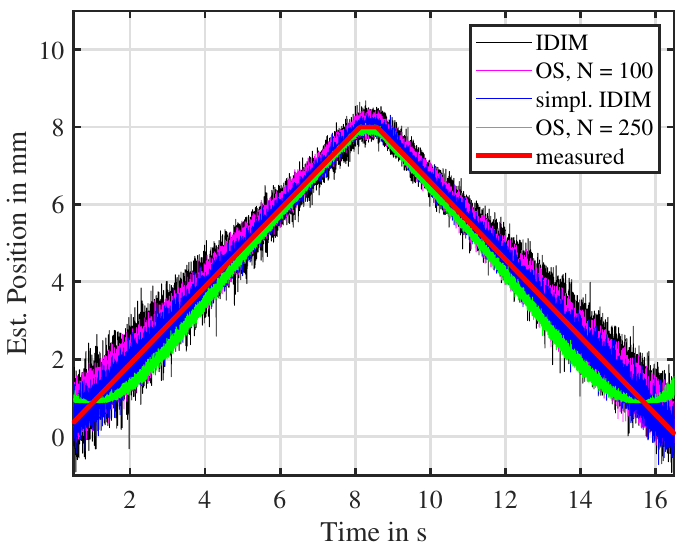
Figure 17. Performance of the obtained sensorless end-position estimator: results are obtained by the IDIM (black), the simplified IDIM approach (blue) and the oversampling approaches with 100 samples (magenta) and 250 samples (green) compared to the position obtained by the high resolution positioning table (red). Results are shown when the actuator has a zero mean current ( i = 0).